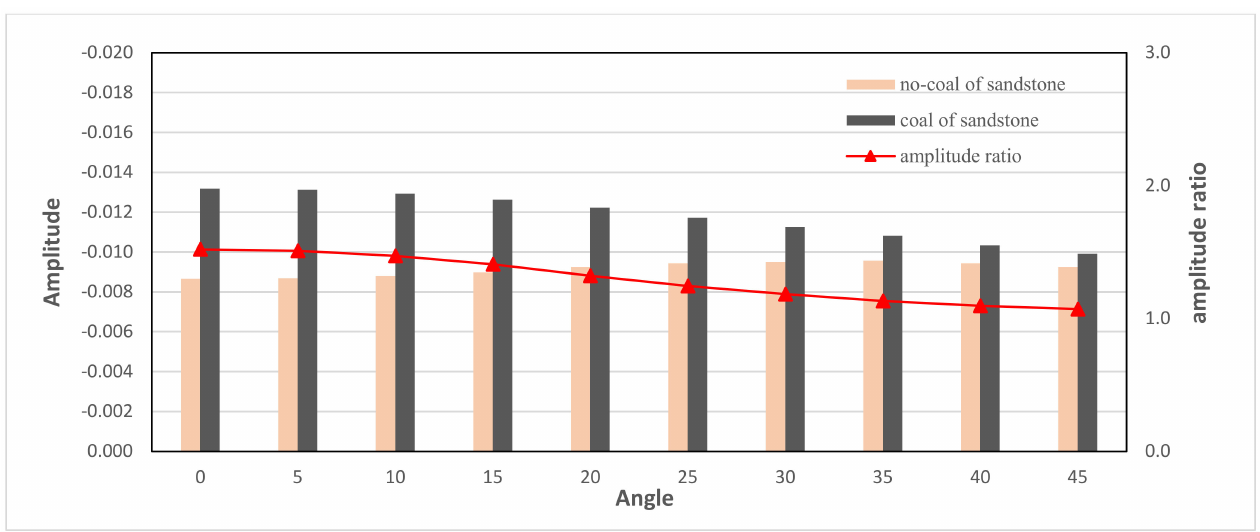
Figure 8. Partial stacked seismic amplitude of sandstone-top surface at different stack